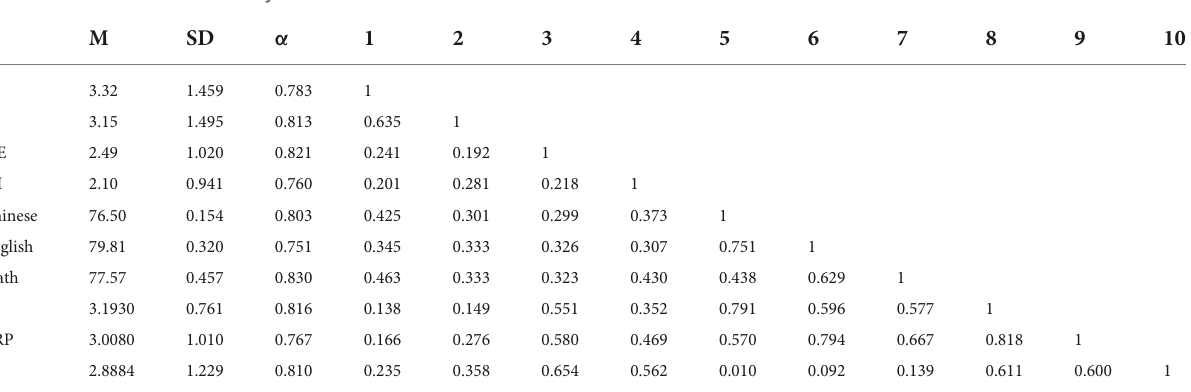
TABLE 3 Bivariate correlation analysis.